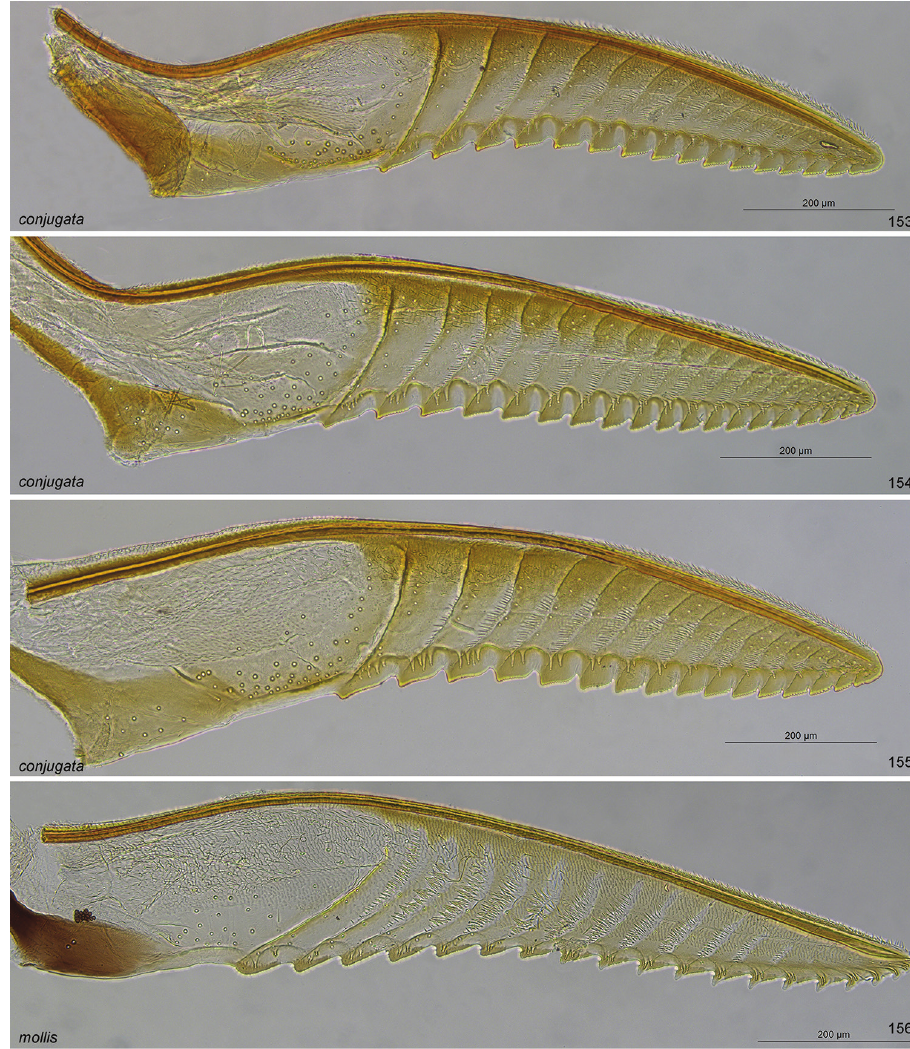
Figures 153–156. Lancets of Pristiphora . 153 conjugata DEI-GISHym31605, reared from Populus tremula 154 conjugata DEI-GISHym20960, reared from Salix pentandra 155 conjugata DEI-GISHym31546, reared from Populus sp. 156 mollis